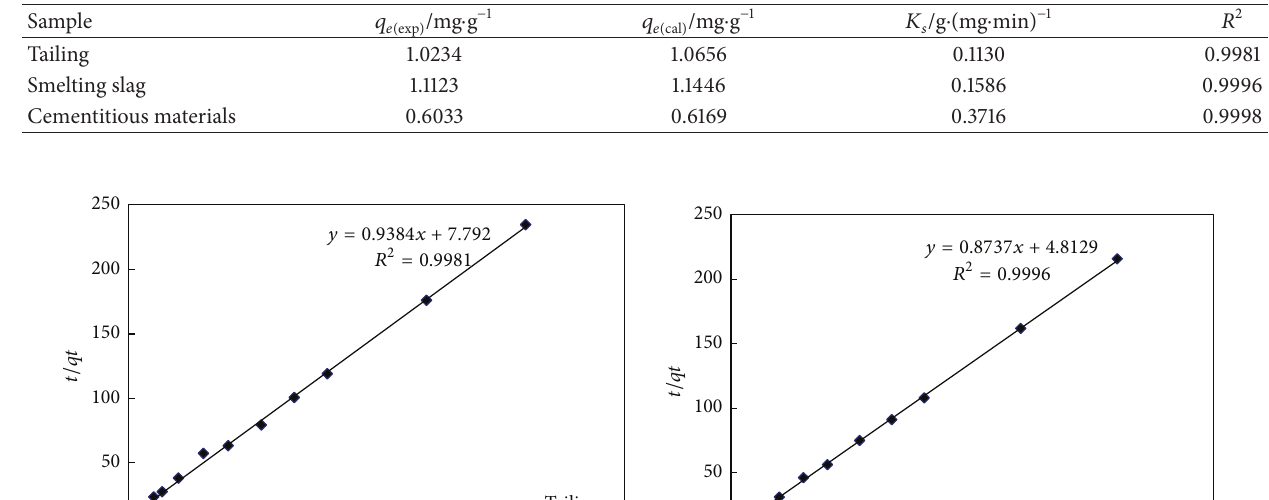
Table 3: The quasi-two-level dynamic model equation data.